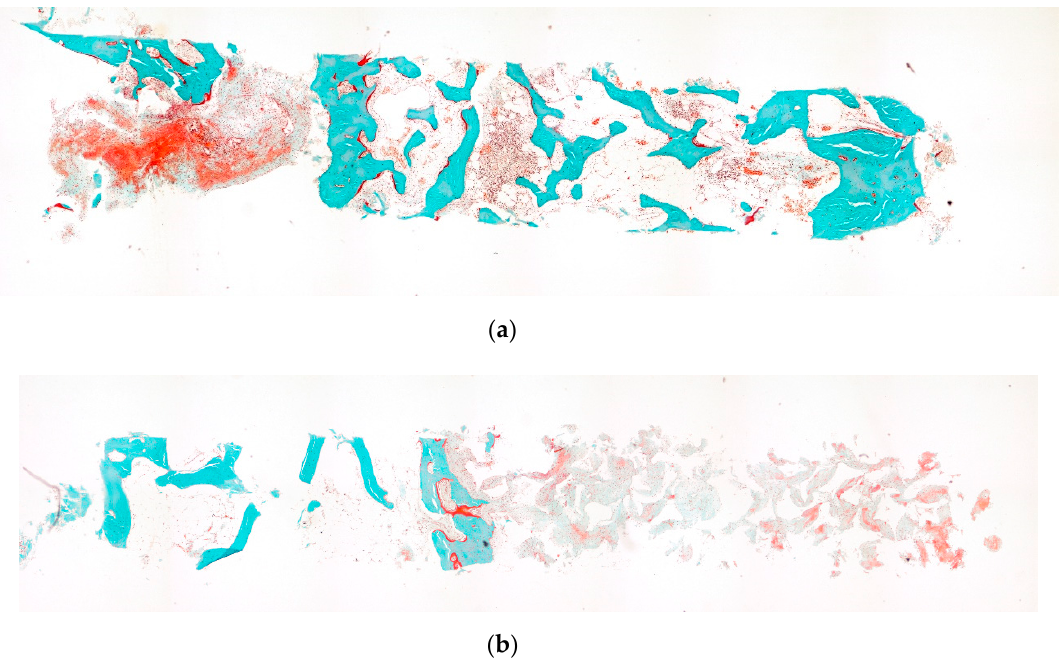
Figure 4. ( a ) Overview of an example of a bone biopsy from the maxilla of a patient, 6 months after a maxillary sinus floor elevation procedure using a mixture of autogenous bone and Straumann ® bone ceramic (60:40), stained with Goldner trichrome staining. Bone is scattered throughout the entire biopsy (original magnification × 10). ( b ) Overview of a not previously shown bone biopsy from the maxilla of a patient, 6 months after a maxillary sinus floor elevation procedure using pure Straumann ® bone ceramic (60:40) as studied by Frenken et al. [12], stained with Goldner trichrome staining. Bone formation at the first 3 mm immediately cranially from the former floor of the maxillary sinus (original magnification ×